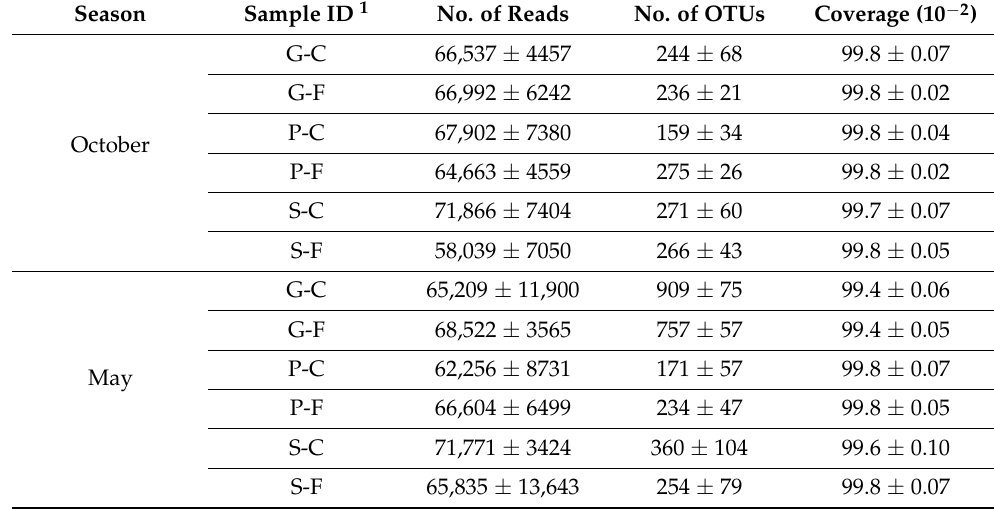
Figure 1. The copy number of ITS region and α -diversity (Shannon and chao1 indices) of fungal community structures of three plant types from two locations over two seasons ( A ). Principal coordinate analysis (PCoA) of the variation in fungal community structures of three plant types from two locations over two seasons ( B ). a, b, and c in ( A ) indicate significant differences between seasons and locations within a plant species. Samples (points) are colored based on different habitats and plant species. Solid points indicate samples obtained on 22 October 2017; the hollow points indicate samples obtained on 10 May 2018. G-C, G. biloba from campus; G-F, G. biloba from the forest; P-C, P. bungeana from campus; P-F, P. bungeana from the forest; S-C, S. chinensis from campus; S-F, S. chinensis from the forest. Table 1. Sequencing summary of each